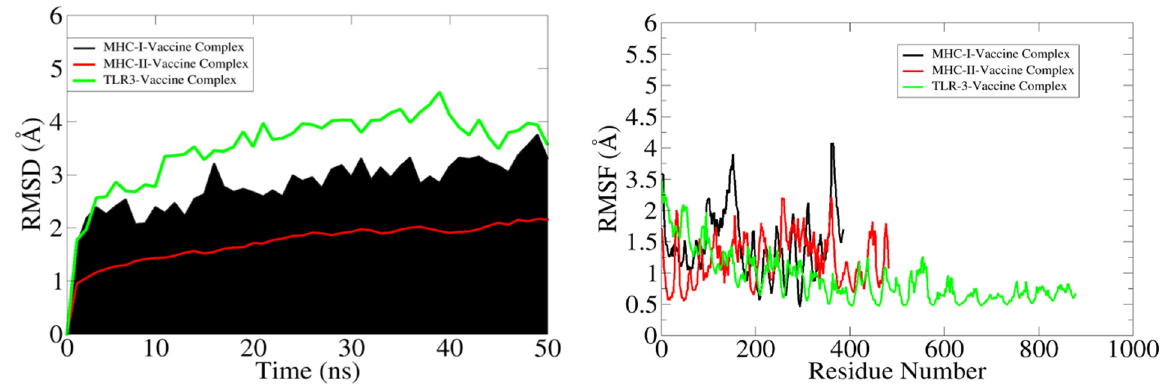
Figure 11. RMSD and RSMF graphs of the docked complexes (MHC-I-vaccine complex (black), MHC-II-vaccine complex (red), and TRL3-vaccine complex